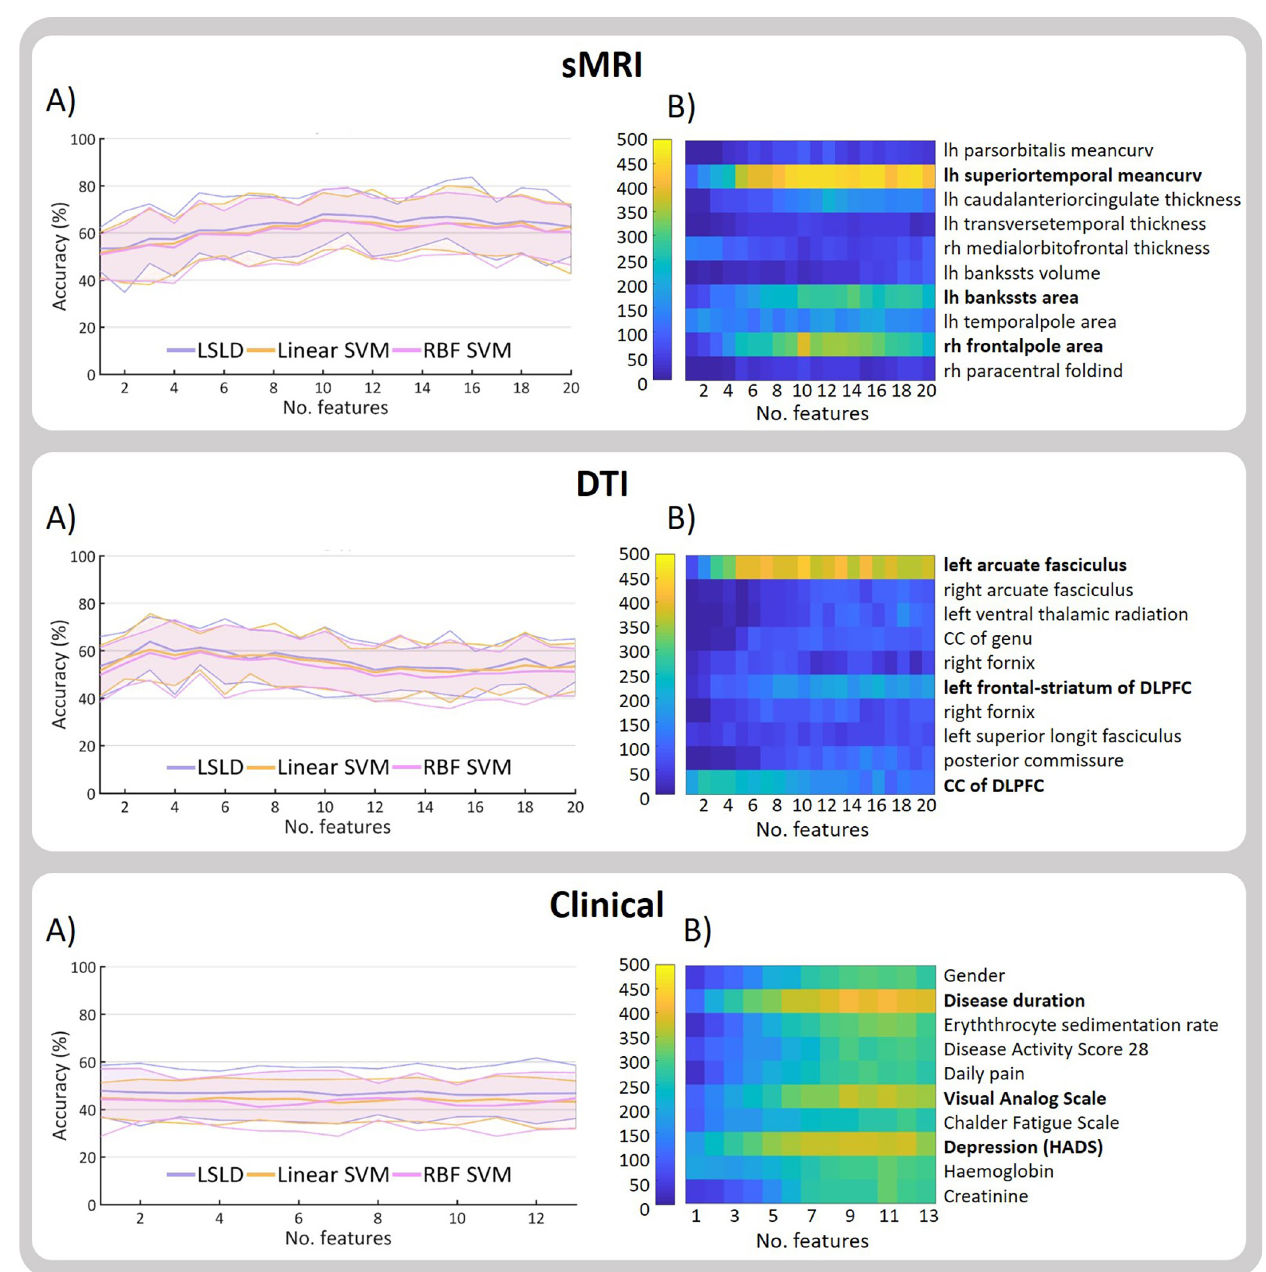
Fig 3. Classification results and feature selection varying the length of the chromosome. A) Accuracy with 95% CI for each classifier for different chromosome length (no. of features). B) Number of times (0–500) that a feature is selected during the 100 iterations of the 5-fold CV for different chromosome lengths for the LSLD (best performing classifier). For summarizing purposes, the ten most selected features for each modality are displayed. CC: corpus callosum. DLPFC: dorsolateral prefrontal cortex. HADS: Hospital Anxiety and Depression Scale. Lh: left hemisphere. Rh: right hemisphere.